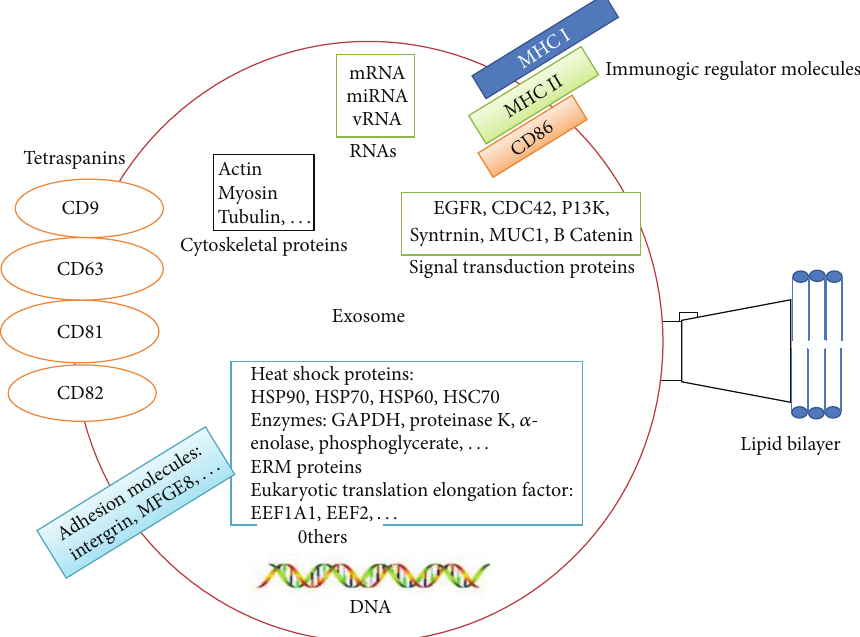
Figure 2: Structure and contents of exosomes: exosomes contain a plasma membrane-derived phospholipid bilayer membrane. Exosomal contents based on the cell type of origin include mRNA, miRNA, and DNA and proteins such as annexins, tetraspanins, MHC molecules, cytoskeletal proteins, enzymes, and signal transduction